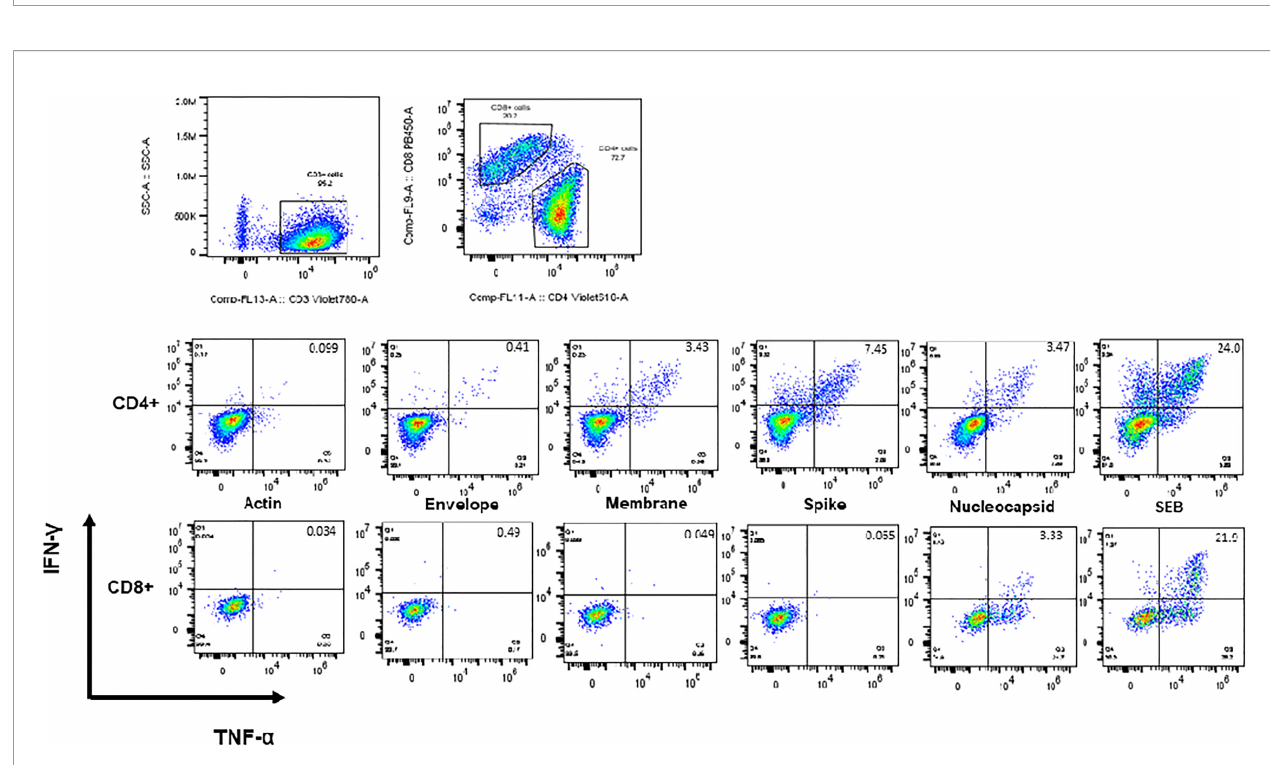
FIGURE 3 | Intracellular staining and fl ow cytometry. Flow cytometric dot plots from a representative CST population expanded from adult convalescent PBMCs showing CD4+ and CD8+ T cells secreting IFN- g and TNF- a in response to viral antigen.